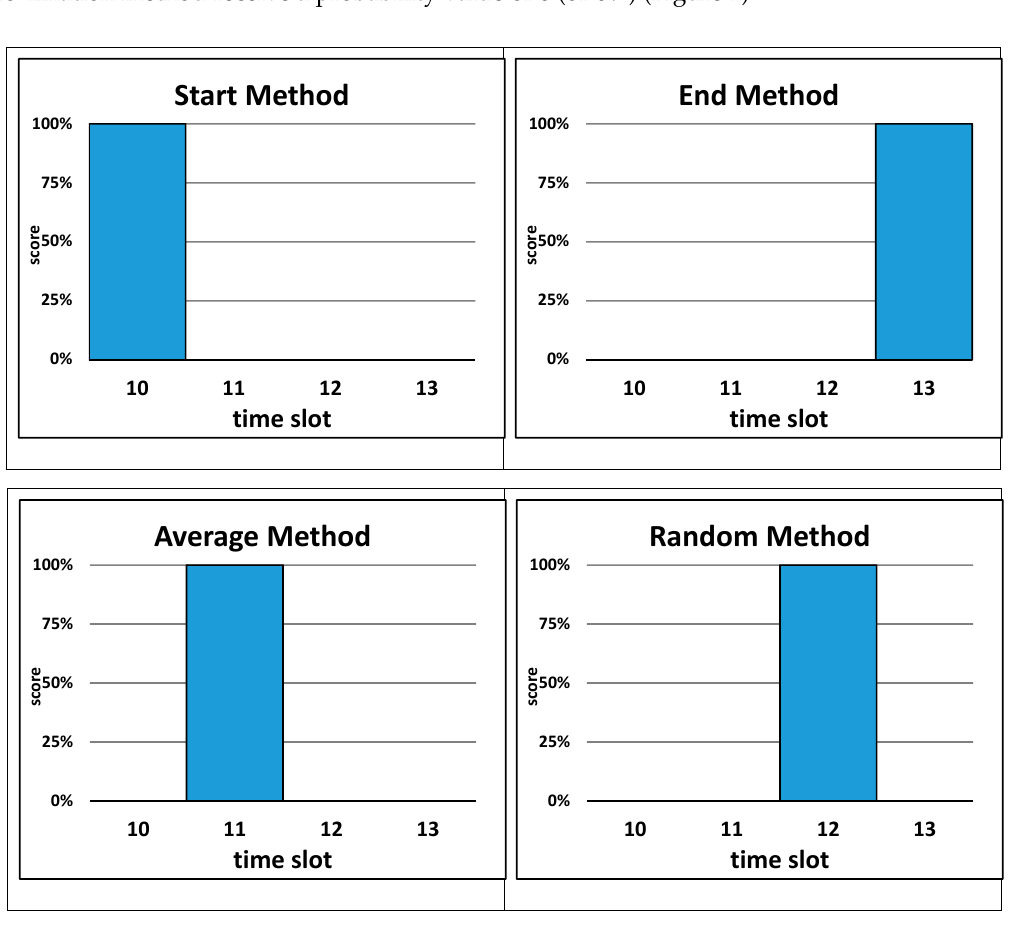
Figure 1. An example of the results of four different naïve temporal approximation methods.